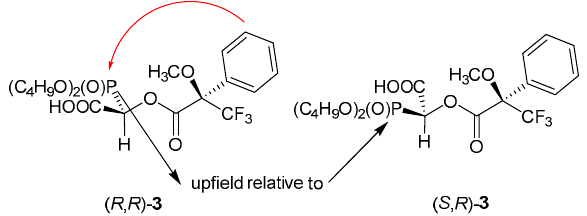
Figure 2. Anisotropic effect of phenyl group on phosphorus atom.